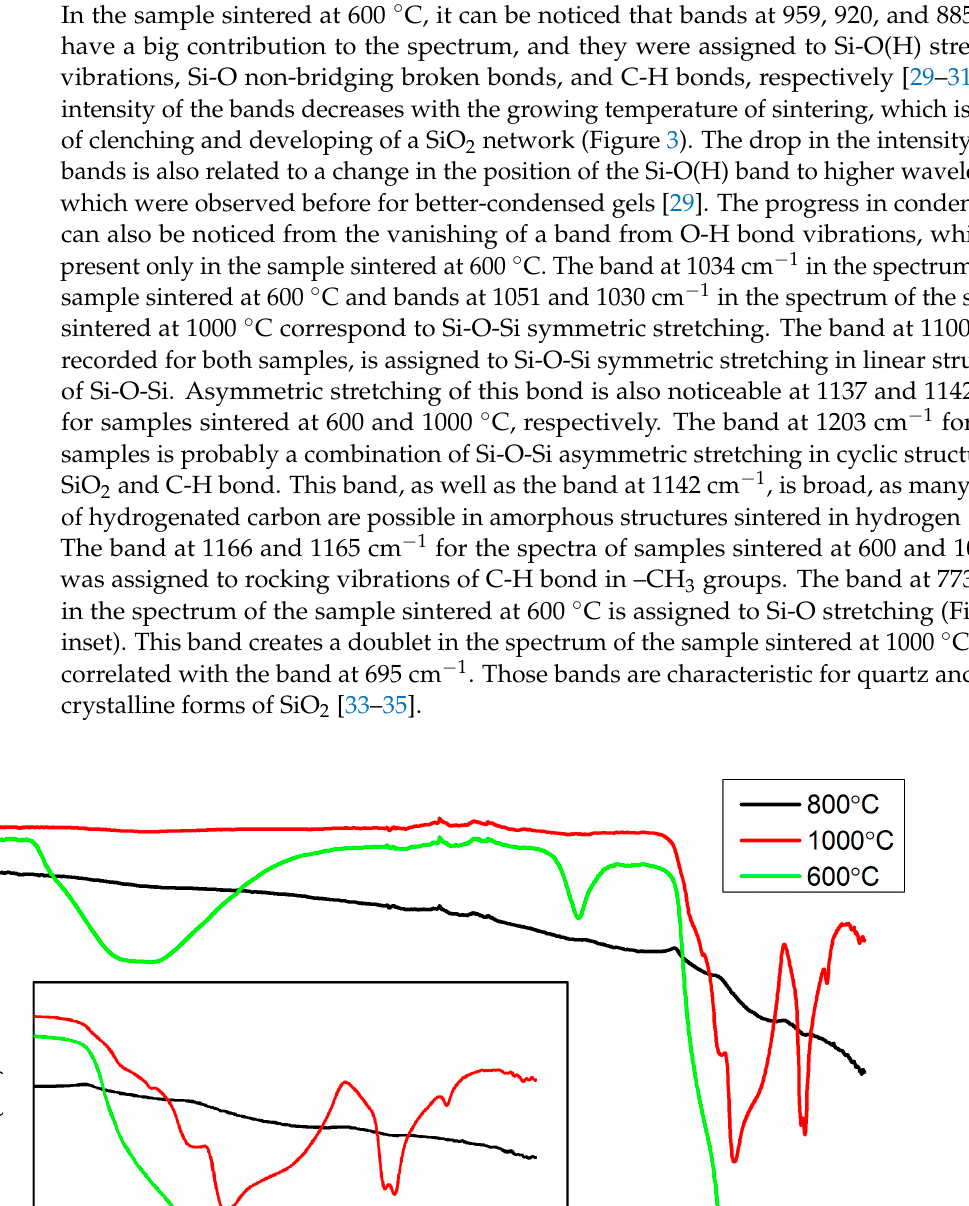
Figure 3 . FTIR spectra of all samples. To clarity, region of 1350–550 cm − 1 is enlarged. Figure 3. FTIR spectra of all samples. To clarity, region of 1350–550 cm